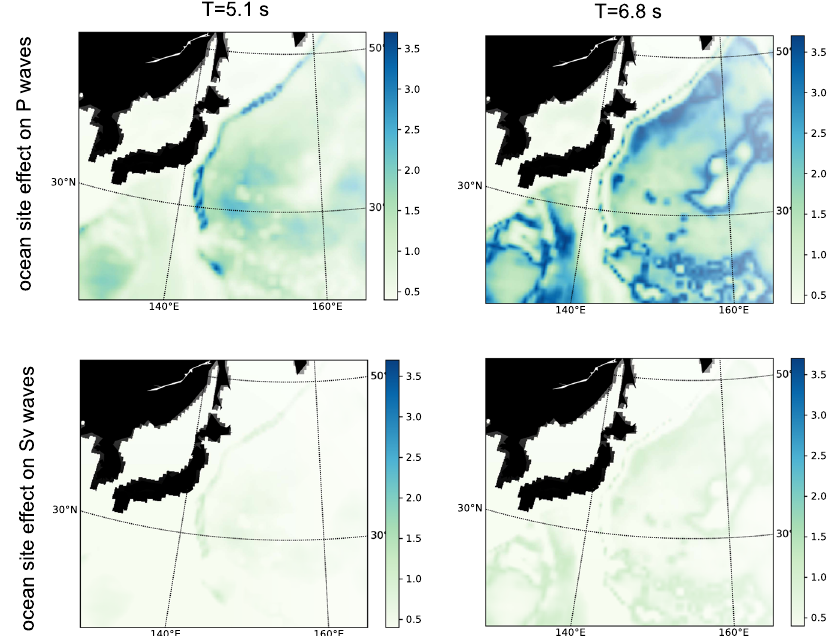
Fig. 5 Ocean site effect on P and Sv waves. Ocean site effect on P (top) and Sv (bottom) waves at 5.1-s (left) and 6.8-s (right)